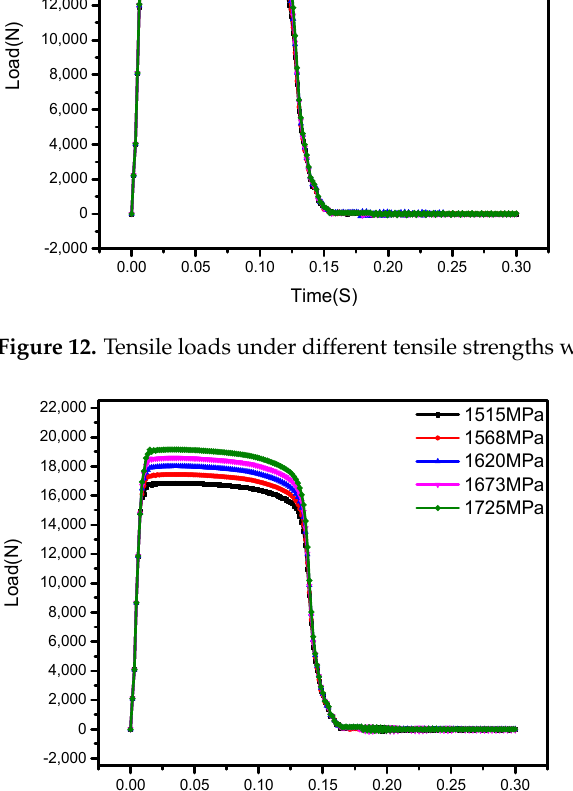
Figure 13. Tensile loads under different tensile strengths with a notch bottom diameter of 3.2 mm. Table 4. Tensile loads of the bolts of different raw material strengths and notch bottom diameters.